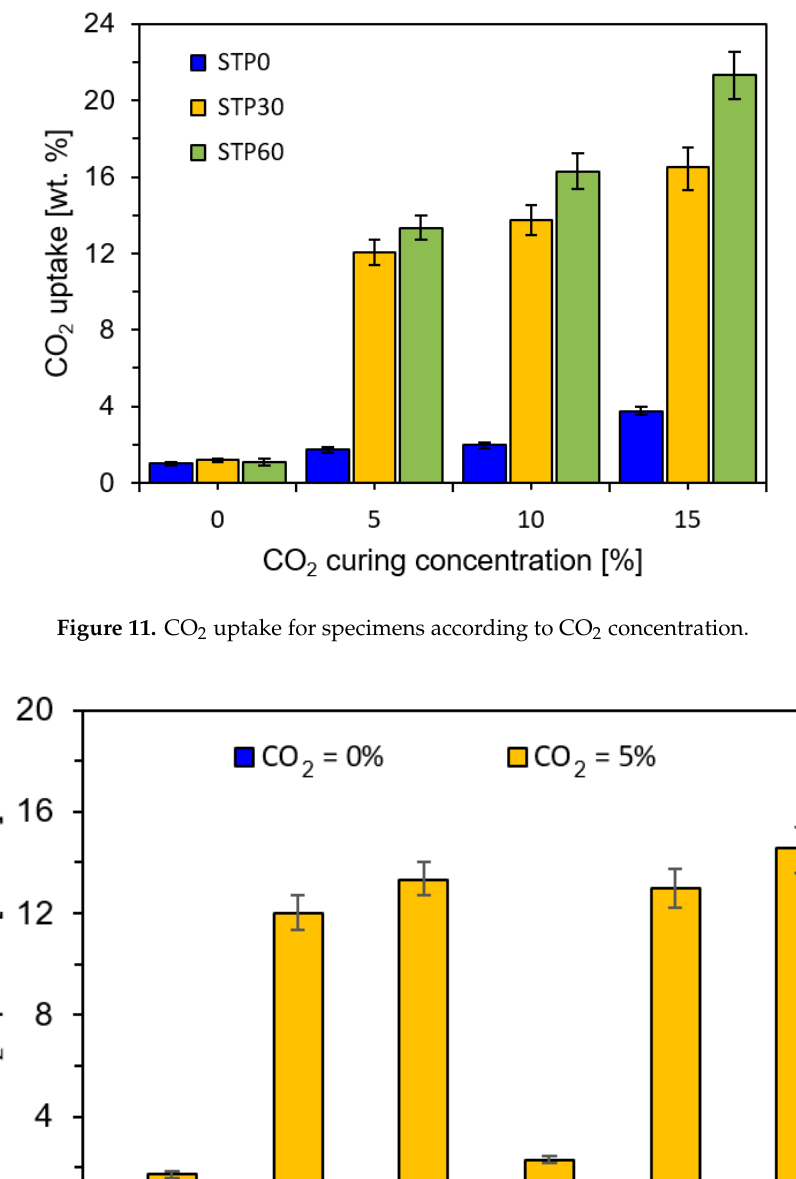
Figure 11. CO 2 uptake for specimens according to CO 2 concentration.